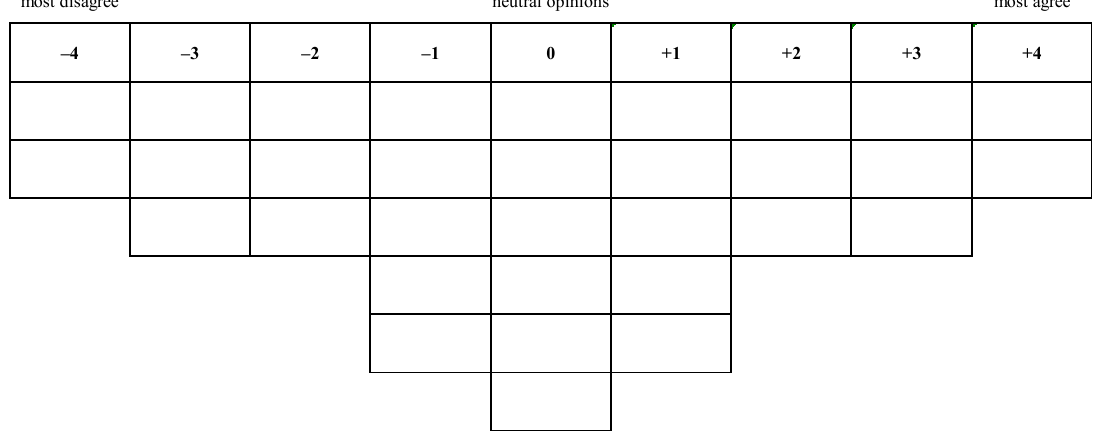
Figure 1. Forced-choice frequency distribution in the Q-sorting process.